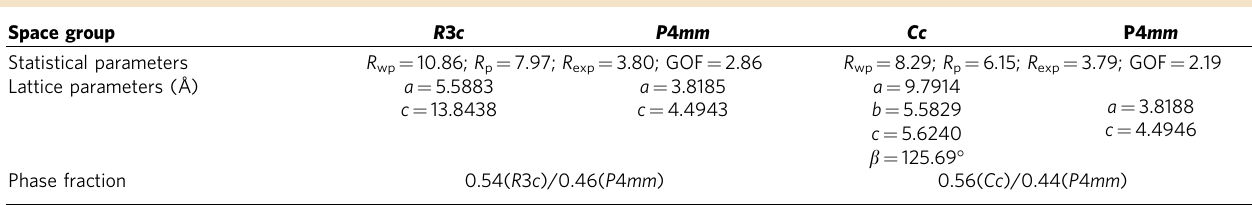
ResultsoftheRietveldrefinementsoftheBi 0.68 Pb 0.32 Fe 0.655 Mn 0.025 Ti 0.32 O 3 powdercomposition,usingmixturemodelswithcoexistenceofrhombohedral R 3 c andtetragonal P 4 mm ,andofmonoclinic Cc and tetragonal P 4 mm. Reliability factors ( R -factors) R wp , R p , R exp and goodness-of-fit indicator (GOF) are